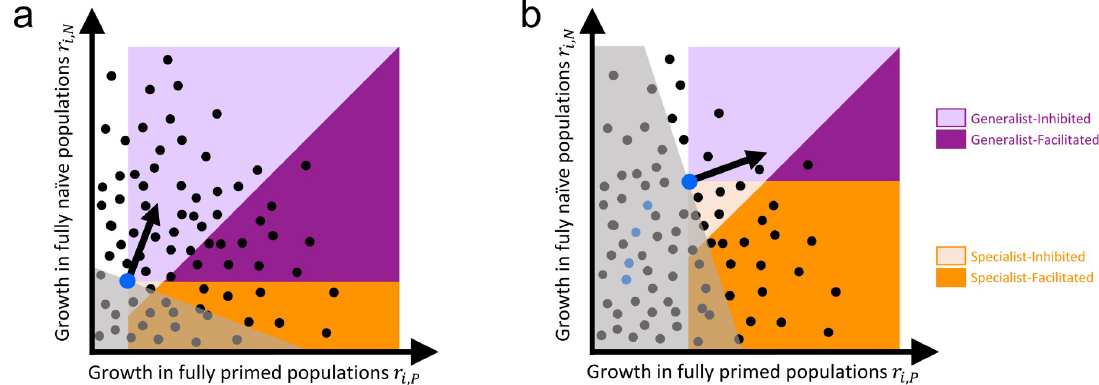
Fig 4. Pathogen adaptation as the fraction of primed individuals increases. Plots of the growth rate of all viable variants in a fully na ï ve and a fully primed population (dots). Large blue dot denotes the phenotype of the current wild type and black arrow indicates direction of selection (i.e., the variants that are most advantageous). Variants in the gray region are disadvantageous. Note that the location of all variants along the r axis is specific to immune response and may be different for natural immunity and different vaccines. Colored i , P regions indicate the 4 different kinds of variants. ( a ) Early in a novel host–pathogen association when a small fraction of hosts are primed. Many potential new variants will be better adapted to both host types (i.e., they will be generalists). ( b ) Later in the association, when the pathogen is better adapted to its novel host (and a larger fraction of hosts are primed). The evolutionary trajectory of successive fixation events leading to the new wild type variant is indicated by the succession of blue dots. Note how the change in the location of the blue dot can affect the typology of some variants (i.e., a variant that was identified as a generalist in the early stage of adaption could later become a specialist relative to the more recent form of the pathogen). Once the level of adaptation is high (panel ( b )), most advantageous variants that appear will tend to be specialists. Even though generalists are still more strongly favored by selection there are fewer of them that can